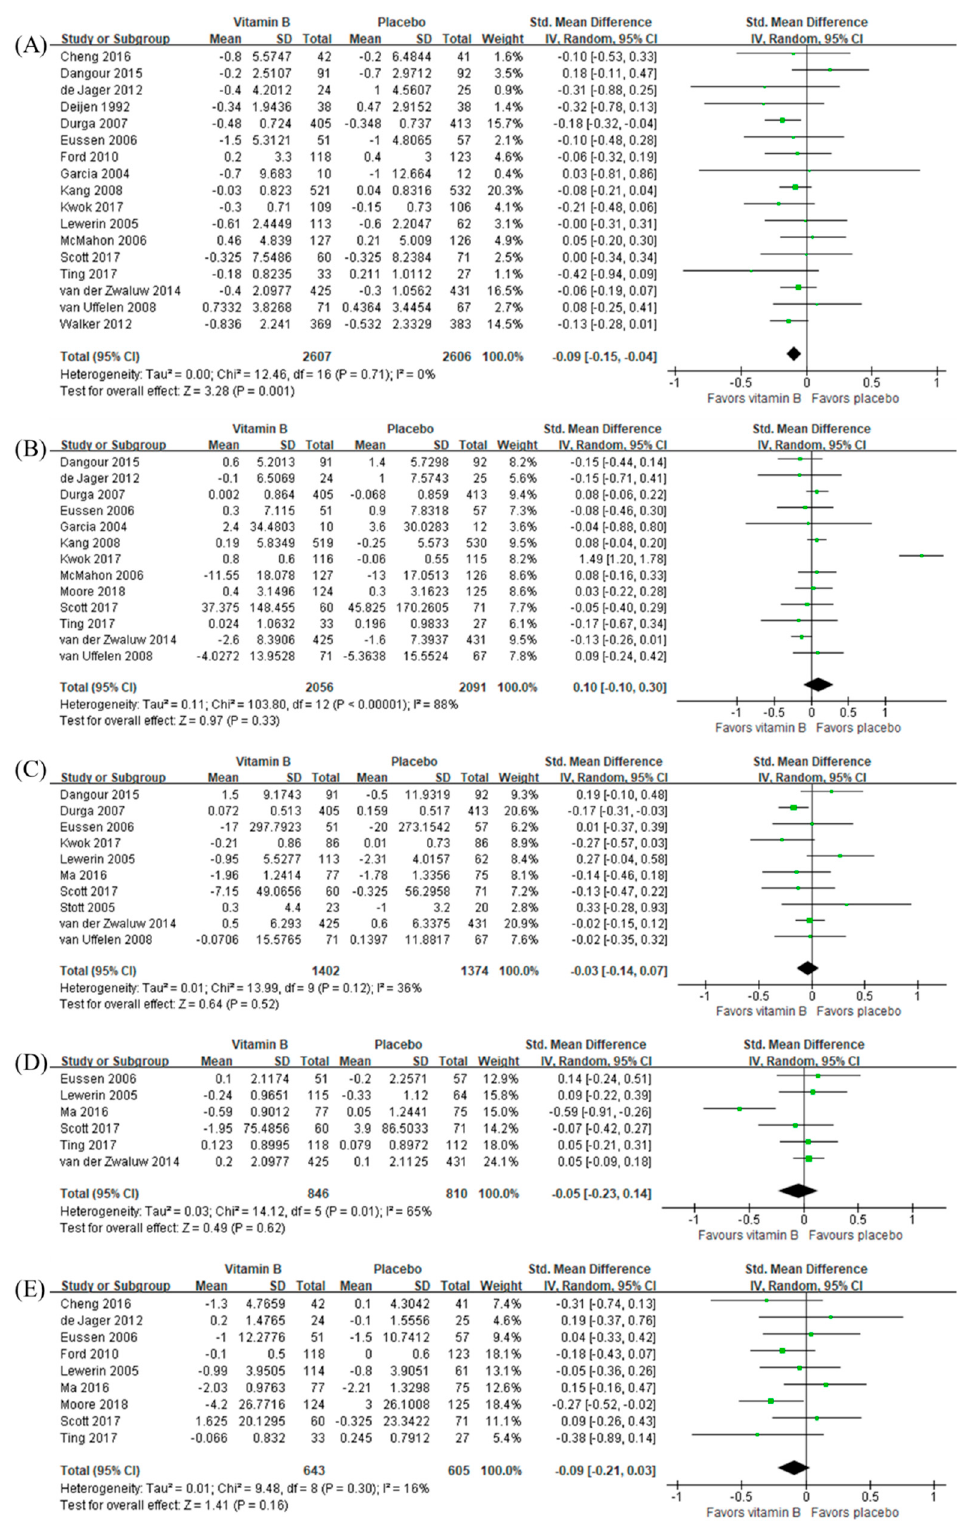
Figure 3. Effects of B vitamins on (A) episodic memory, (B) executive function, (C) processing speed, Figure 3. E ff ects of B vitamins on ( A ) episodic memory, ( B ) executive function, ( C ) processing speed, (D) attention, and (E) visuospatial function in terms of change from baseline. ( D ) attention, and ( E ) visuospatial function in terms of change from